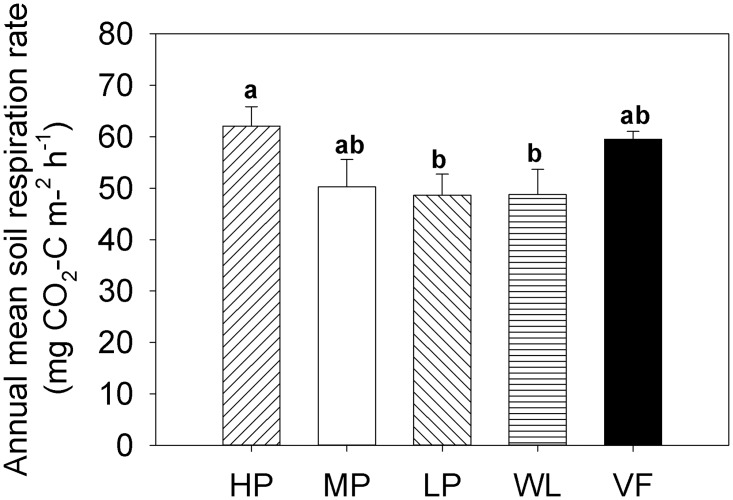
Annual mean soil respiration efflux in five adjacent experimental sites.HP = tea garden with high production, MP = tea garden with medium production, LP = tea garden with low production, WL = woodland, VF = vegetable field. Vertical bars indicate standard error. Bars labelled with the different lowercase letters at the same site denote significant difference at p<0.05.